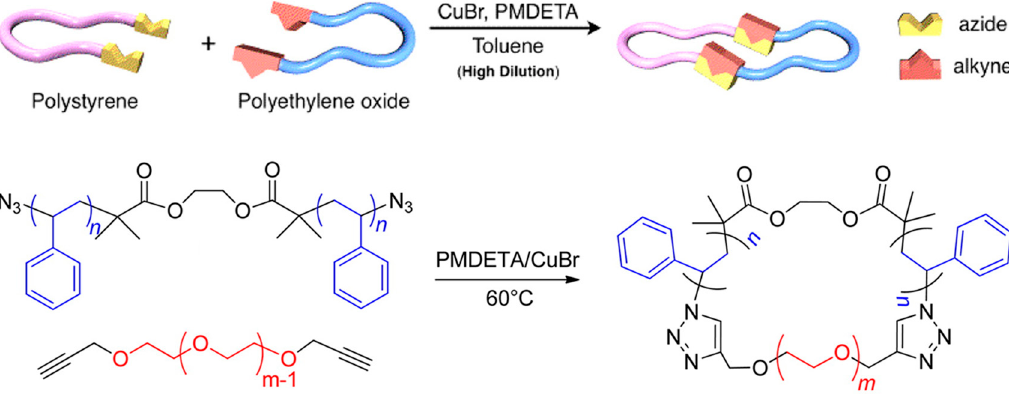
Figure 5. Synthesis of cyclic PS- b -PEO copolymer. Reprinted from Reference [11]. (Copyright (2012) American Chemical Society).